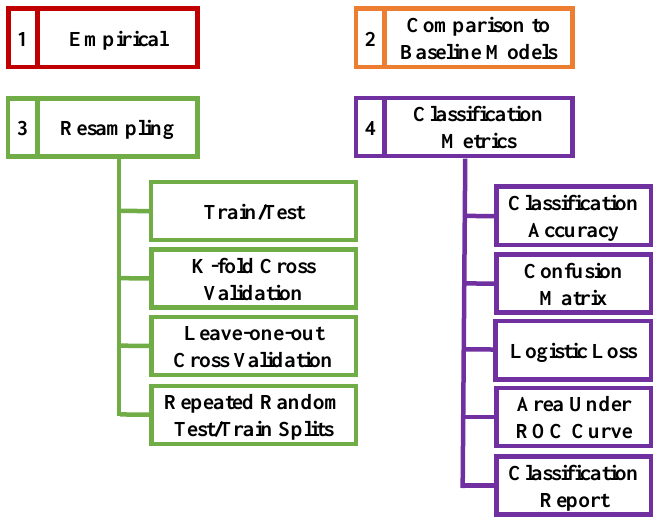
Figure 5. Methods of assessment of machine learning classification algorithms (ROC: Receiver Operating